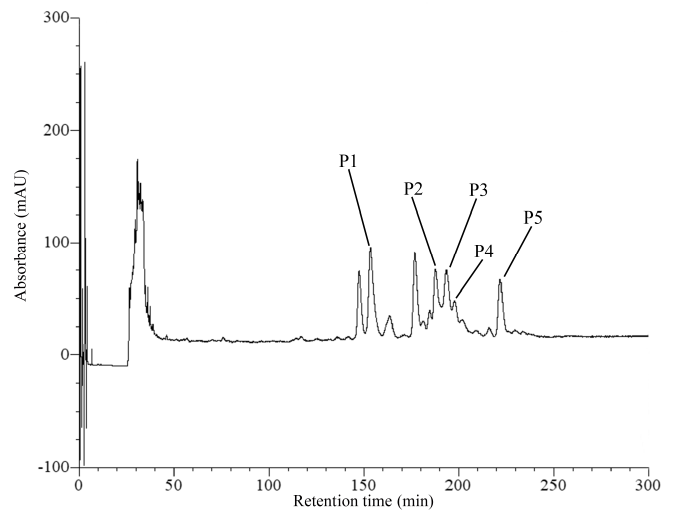
Figure 1. Reversed-phase chromatogram of anti-MRSA substances from SPR-20. The peak signal was monitored at 214 nm. Arrows indicate the active peaks that corresponded to the anti-MRSA